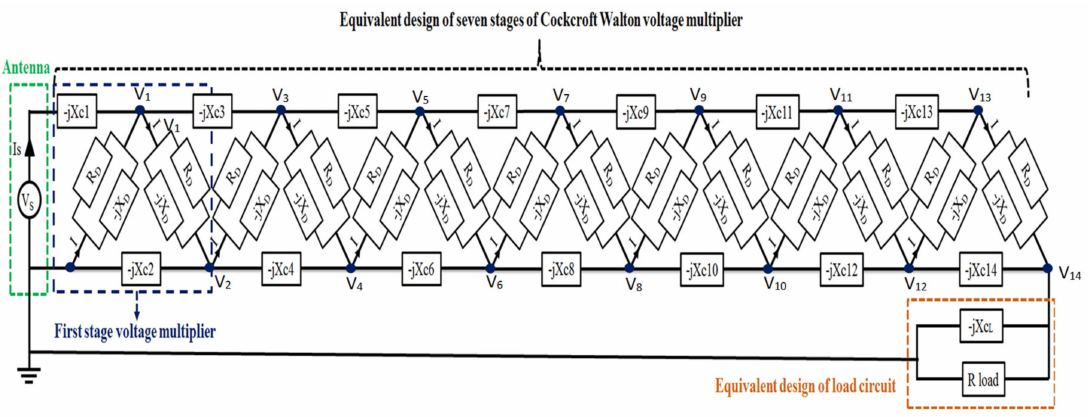
Figure 7. Linearized model of Cockcroft–Walton voltage